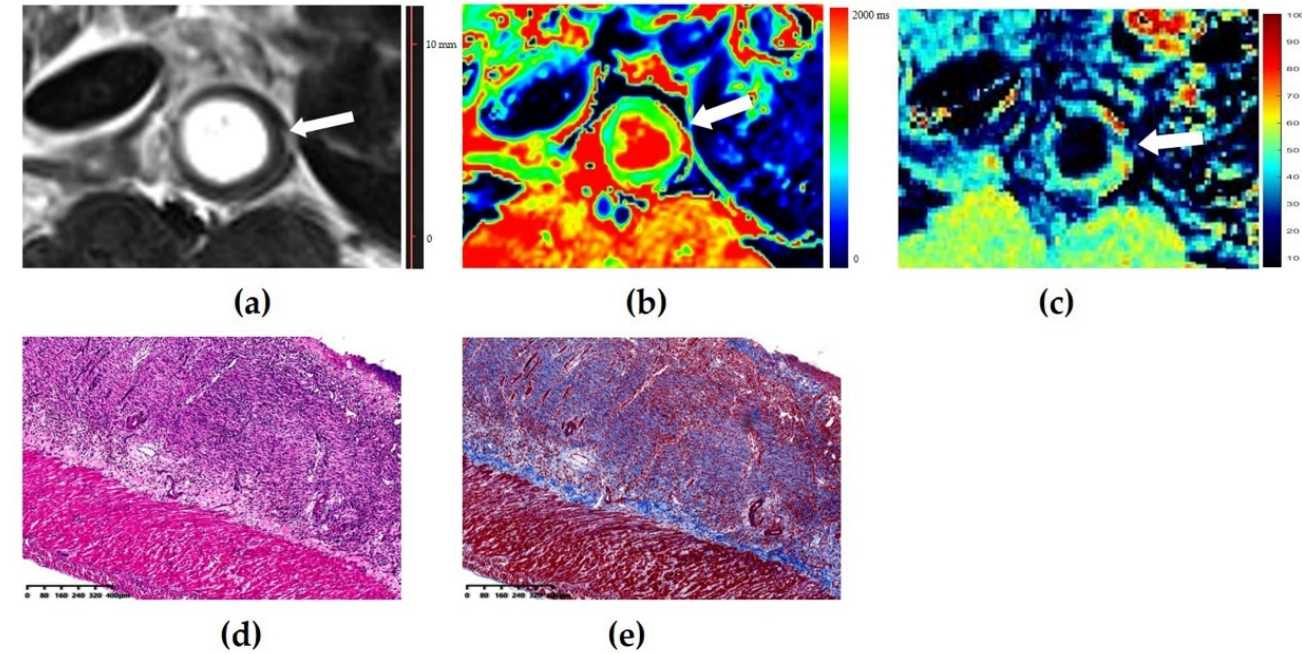
Figure 5. Images of a severely fibrotic and severely inflammatory bowel wall of rat. ( a ) Axial T2-weigheted imaging reveals a markedly thickened bowel wall. ( b ) The T 1 map shows that the T 1 value is 1549 ms (higher than the cutoff value of 1266 ms), thus indicating the presence of moderate-to-severe fibrosis. ( c ) The normalized magnetization transfer ratio (MTR) of the corresponding bowel wall is 0.83 (higher than the cutoff value of 0.72), which suggests the presence of a moderate-to-severe fibrosis. ( d ) Hematoxylin and eosin (magnification = 4.92) and ( e ) Masson’s trichrome staining (magnification = 4.96) depicts severe inflammation (score = 3) and severe fibrosis (score = 3). In this case, the diagnosis performance of the T 1 value is equal to that of normalized MTR.